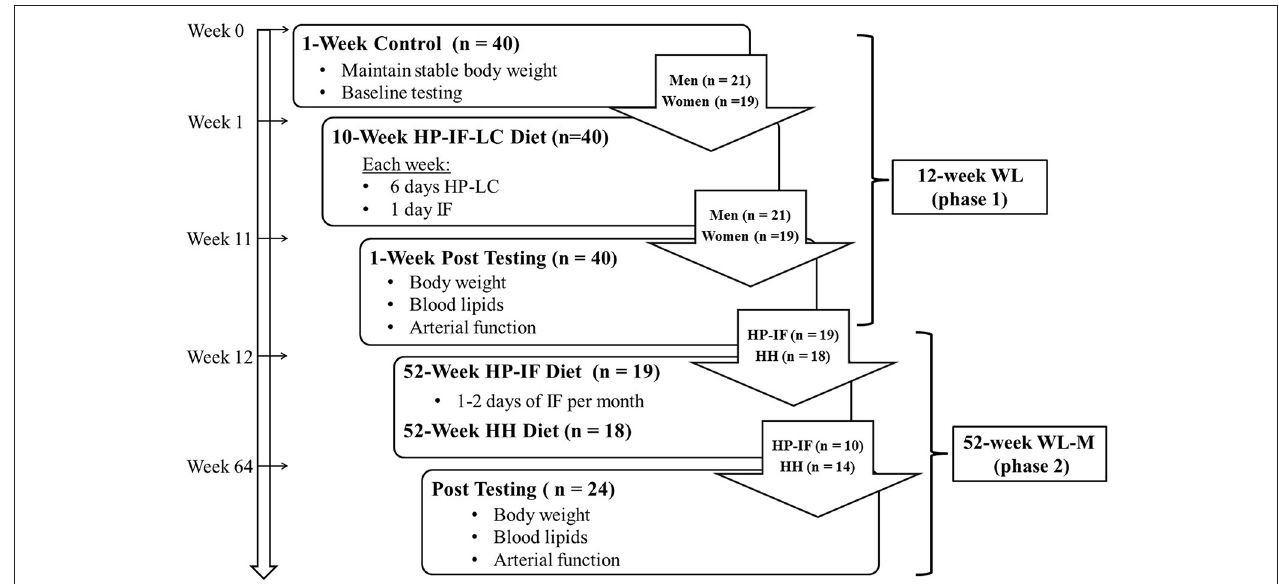
FIGURE 1 | Schematic illustrating the experiment timeline comprised of a 12-week WL (phase 1), followed by a 52-week WL-M (phase 2). HP-IF-LC, high-protein, intermittent fasting, low-calorie; HH diet, heart healthy diet; WL, weight loss; WL-M, weight loss